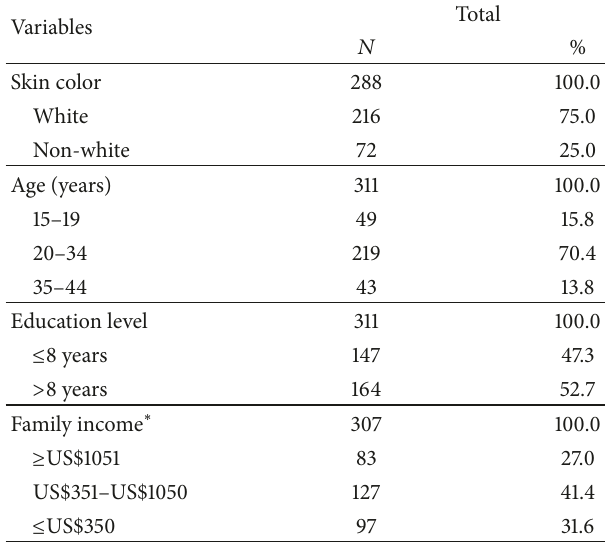
Table 1: Study population sociodemographics ( 𝑛 = 311